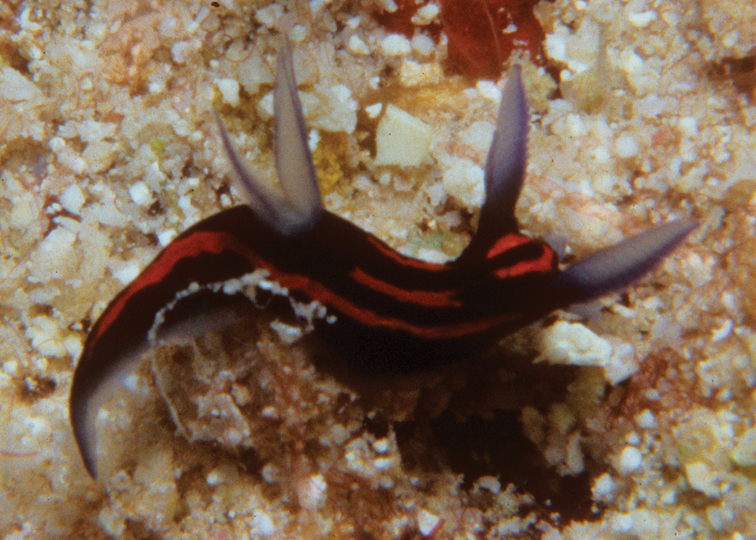
Roboastra gracilis, 20 mm, Maldives, photo: J Hinterkircher (no spcm).